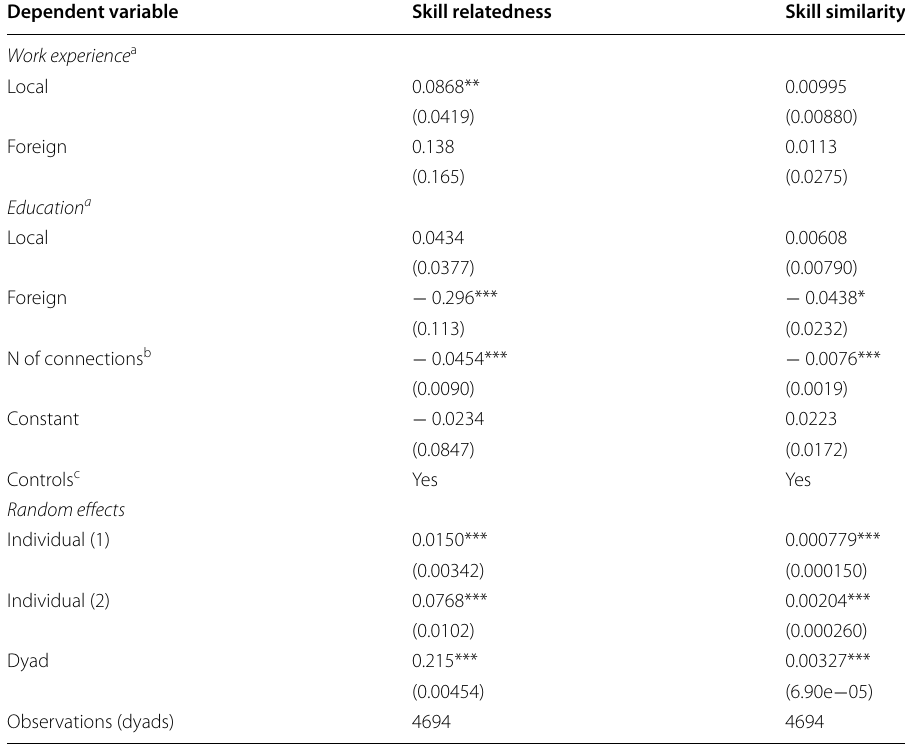
Table 4 The impact of education and work experience on skill relatedness and skill